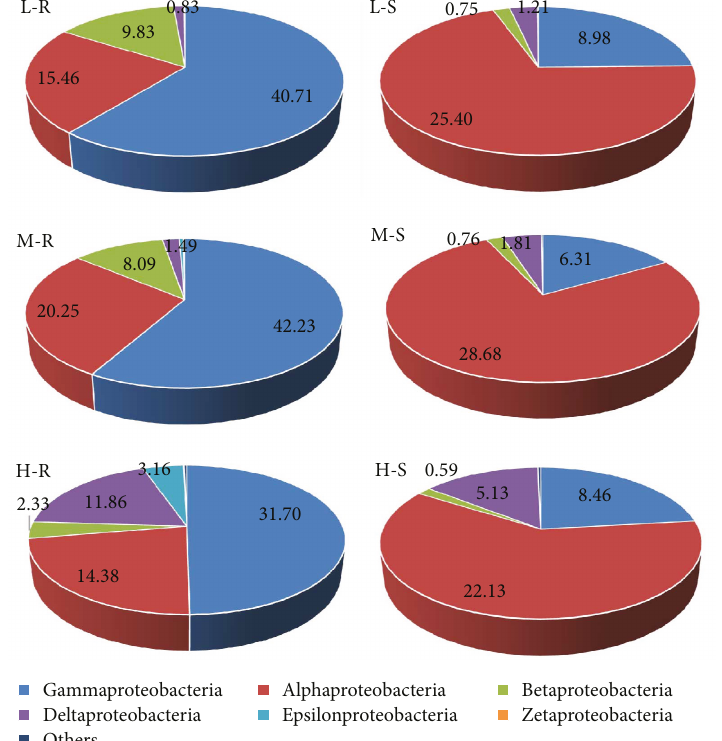
Figure 4: Relative abundance of Proteobacteria at the class level. Other Proteobacteria with relative abundance of < 0.01% in each sample are included as “ Others ” .